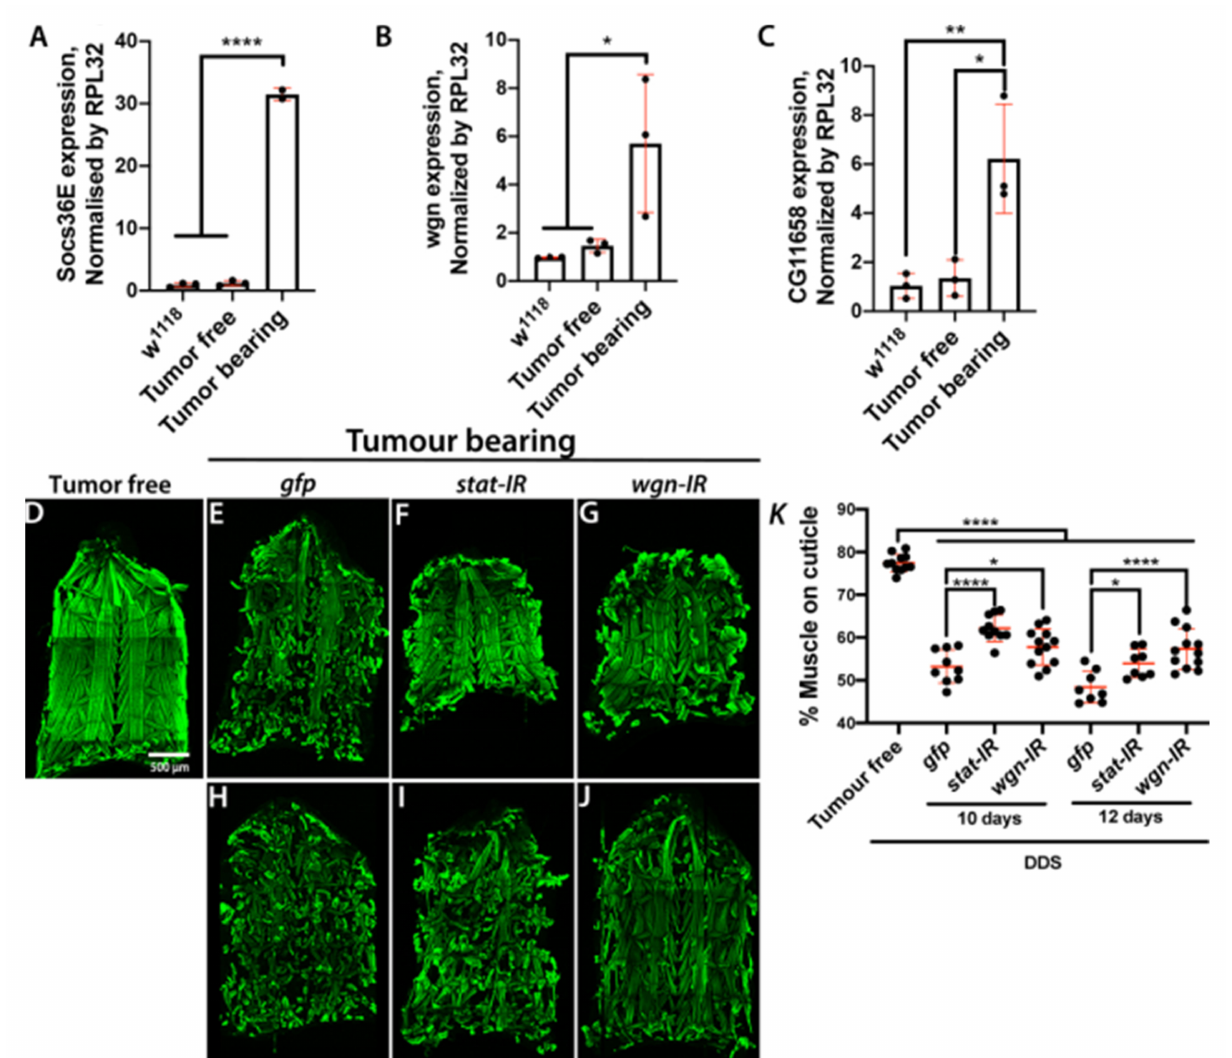
Figure 6. Muscle JAK/STAT and TNF- α signalling drives tissue wasting. ( A – C ) mRNA expression levels of the JAK/STAT pathway target Socs36E ( A ), the TNF- α /Egr receptor wgn ( B ) and the Atrogin 1 homologue CG116758 ( C ) in skeletal muscle from 6-day old wild type larvae ( w 1118 ) or larvae with dual driver system (DDS) generated control (Tumour free) or scrib 1 ; Ras V12 clones (Tumour bearing). ( D – J ) Cuticles from larvae with DDS generated control clones (Tumour free; 6 day-old) ( D ) or scrib 1 ; Ras V12 clones (Tumour bearing) with muscle specific concomitant overexpression of a control transgene ( gfp ), stat RNAi ( stat-IR ) or wgn RNAi ( wgn-IR ) ( E – J ). Cuticles of tumour bearing animals were assessed at 10 days ( E – G ) and 12 days ( H – J ) of larval age (AED). Muscle actin was stained with Phalloidin (green). ( K ) Quantification of the percentage of cuticle covered by muscle in larvae of genotypes and ages as in ( D – J ). All graphs show one-way ANOVA with Tukey post hoc correction. Mean ± SEM is indicated. * p ≤ 0.05; ** p ≤ 0.01; **** p ≤ 0.0001. DDS: dual driver